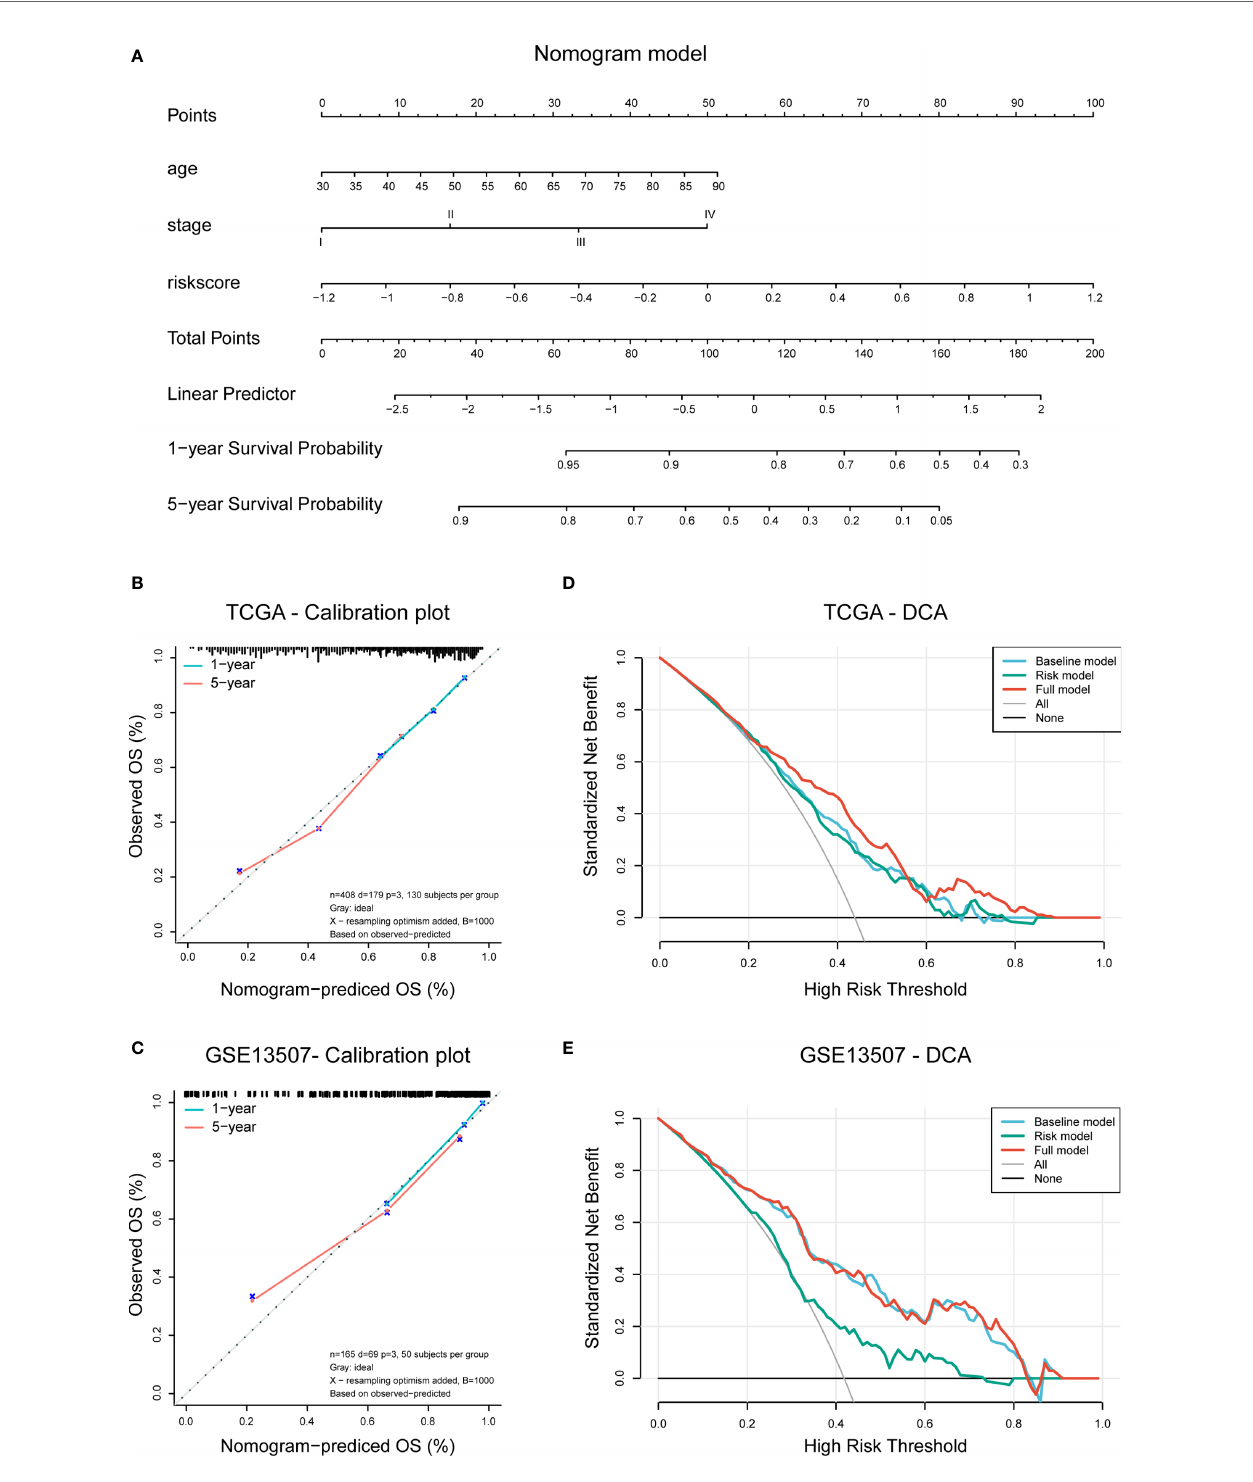
FIGURE 9 | Construction and validation of the nomogram. (A) Nomogram based on age, tumor stage, and risk score. (B, C) Calibration plots of the nomogram for predicting the probability of OS at 3- and 5-year in the TCGA BLCA and GSE13507 cohorts. (D, E) DCA plots evaluating the predictor ef fi cacy of nomogram in the TCGA BLCA and GSE113507 cohorts (Baseline model: age and stage included; Risk model: risk score included; Full model: the